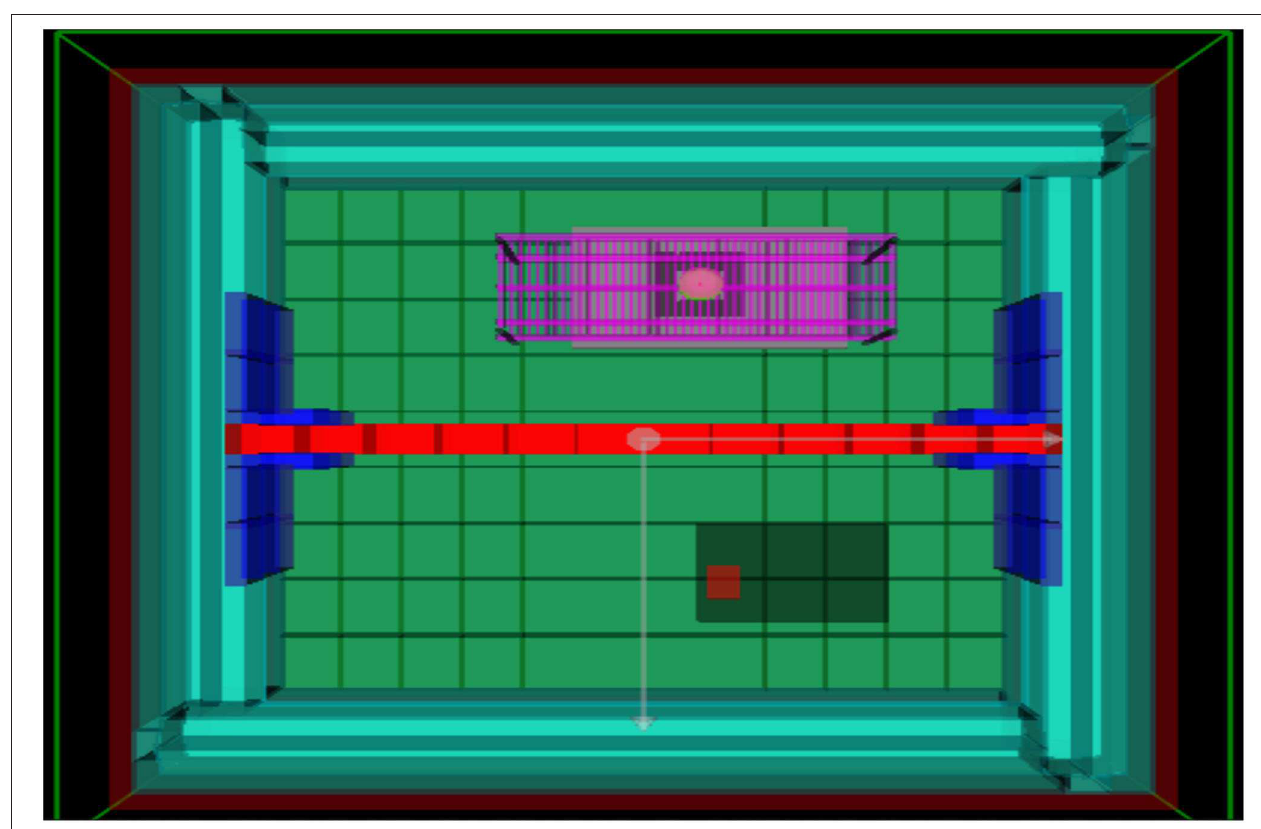
FIGURE 2 | Geometry of lead-lined chamber in GEANT4, view from above. The lead wall is marked in red, separating the container into a low and artificial background radiation environment. The 137 Cs γ -source is located on the purple platform above the one plate reader, providing the artificial background